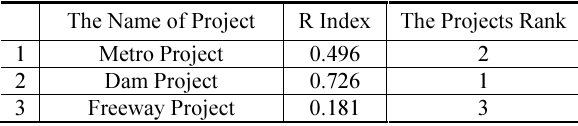
Table 2. The final project ranking based on the